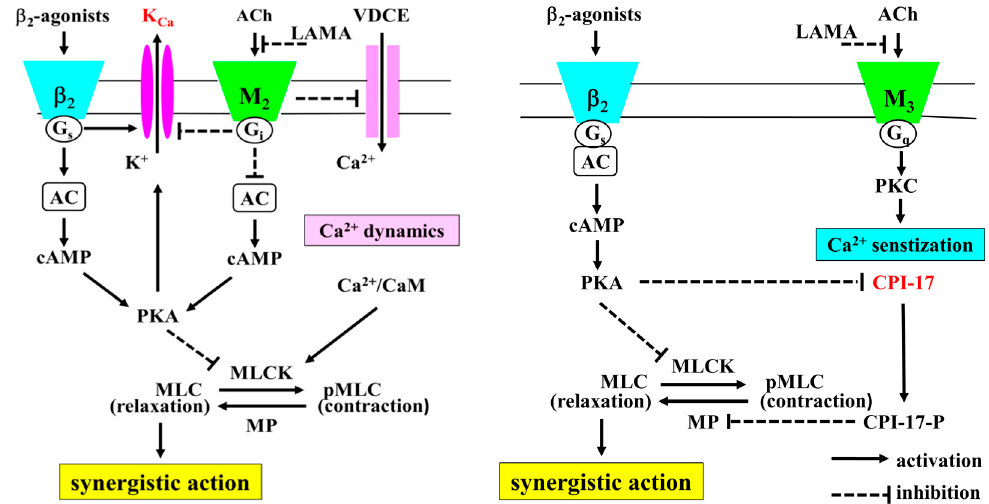
Figure 1. The intracellular mechanisms of the synergistic effects between β 2 -adrenoceptor agonists and muscarinic receptor antagonists. Not only Ca 2+ sensitization but also Ca 2+ dynamics contributes to the synergistic effect of β 2 -adrenoceptor agonists and muscarinic receptor antagonists (cross talk between β 2 -adrenoceptors and muscarinic receptors). In Ca 2+ dynamic, Ca 2+ influx by VDCE is involved in this phenomenon. VDCE is regulated by membrane potential via K Ca channel activity, which is augmented by G s coupled to β 2 -adrenoceptor, in contrast, attenuated by G i coupled to muscarinic M 2 receptors (dual regulation by G proteins). Increased intracellular Ca 2+ concentration causes contraction by activation of MLCK via Ca 2+ /CAM processes (Ca 2+ -dependent contraction). In Ca 2+ sensitization, PKC is involved in this phenomenon. PKC is activated by muscarinic M 3 receptors. PKC inhibits MP activity via CPI-17 processes. Inactivation of MP causes contraction by increased sensitivity to intracellular Ca 2+ (Ca 2+ -independent contraction). CPI-17 MP is activated by PKC, in contrast, inhibited by PKA. K Ca channels and CPI-17 are key molecules for this synergistic effect via the cross talk between these two receptors. This synergism may be caused by Ca 2+ dynamics (tone with changes in concentration of intracellular Ca 2+ ) via K Ca channel activity reciprocally regulated by G proteins (G s and G i ), and caused by Ca 2+ sensitization (tone without changes in concentration of intracellular Ca 2+ ) via CPI-17 reciprocally regulated by protein kinases (PKA and PKC). K Ca : large-conductance Ca 2+ -activated K + channels. VDCE: voltage-dependent Ca 2+ entry. ACh: acetylcolin, LAMA: long-acting muscarinic receptor antagonist. AC: adenylate cyclase. PKA: protein kinase A. PKC: protein kinase C. CPI-17: C-kinase-potentiated protein phosphatase-1 inhibitor. CaM: calmodulin. MLCK: myosin light chain kinase. MP: myosin